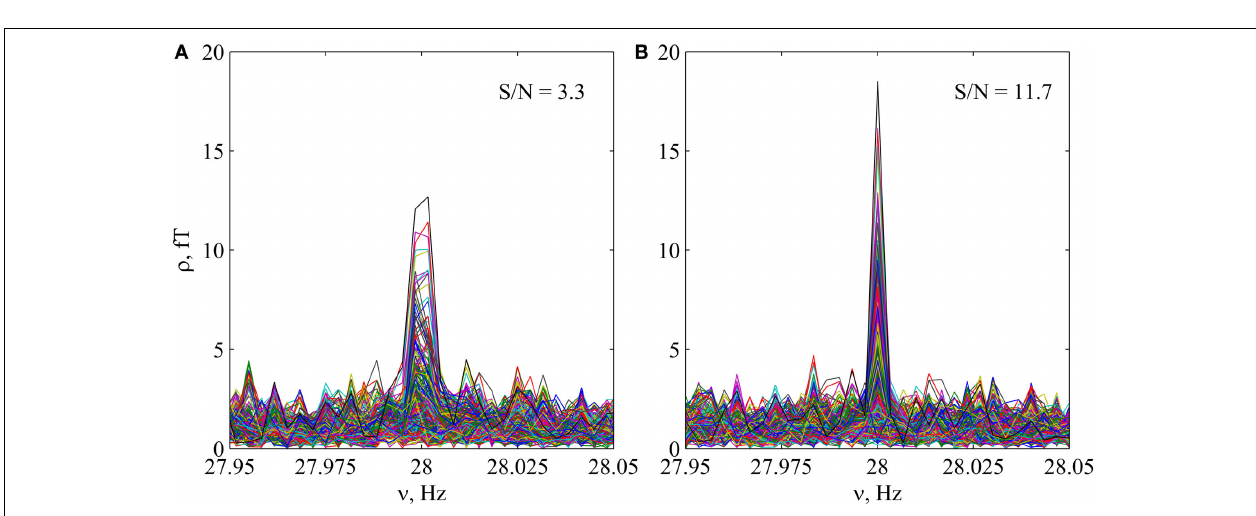
FIGURE 2 | Tuning of the precise multichannel Fourier spectrum for the stimulus frequency in auditory MEG experiment JG03_01. (A) Multichannel spectrum close to the second harmonic of the stimulus, calculated using T = 300s. (B) The same spectrum, calculated using